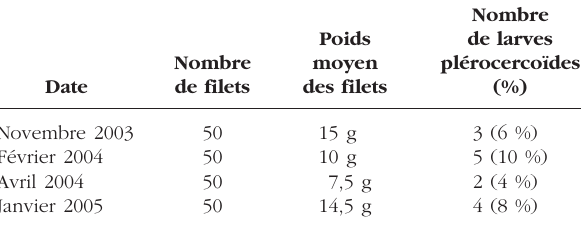
Tableau I. – Résultat de l’examen de 200 filets de perche prélevés en 2003, 2004 et 2005 dans le lac